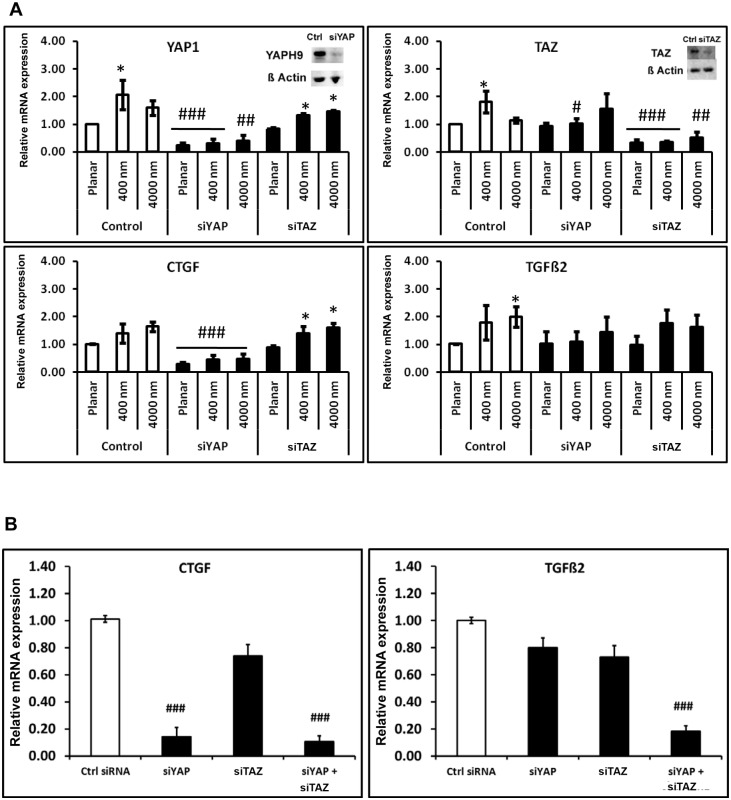
Interaction of YAP & TAZ and their modulation of TGFβ2 and CTGF in immortalized corneal epithelial cells (hTCEpi).(A) Knockdown of YAP did not alter mRNA expression of TAZ and knockdown of TAZ did not alter the mRNA expression of YAP indicating they do not moderate each other’s expression. No specific trends were observed for TGFβ2 mRNA expression after YAP or TAZ were individually knocked down. CTGF mRNA expression was inhibited after singular knockdown of YAP. Experiments were performed three times and a minimum of three reactions were run for each sample. Figure insets are Western blots demonstrating knockdown of YAP and TAZ on the protein level. (B) Simultaneous knockdown of YAP and TAZ inhibits TGFβ2 and CTGF mRNA expression in immortalized corneal epithelial cells. Results are mean ± standard deviation, n = 3 reactions. Statistical comparisons were made by ANOVA followed by Dunnett’s multiple comparison test. *p<0.05 compared with planar control, ##p<0.01, ###p<0.001 compared with control non-targeted siRNA.